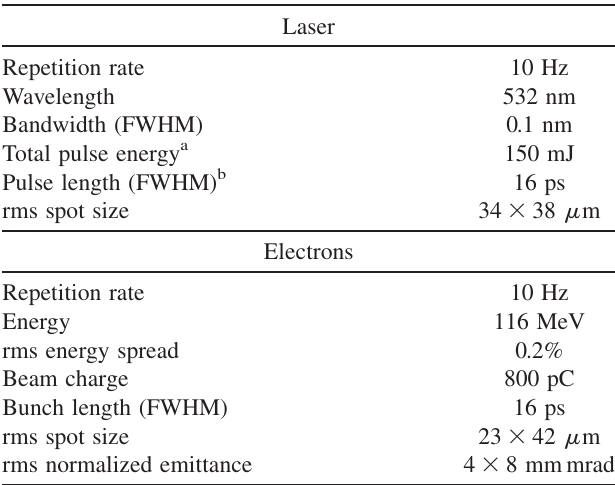
TABLE II. Laser and electron beam parameters at the interac- tion point for nominal